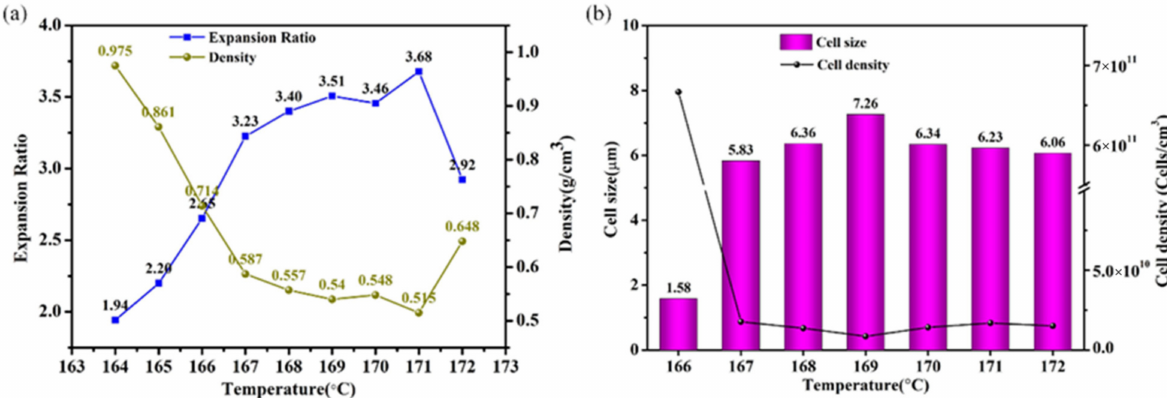
Figure 5. ( a ) The density and expansion ratio of the PVDF/10 wt% CNTs/10 wt% Ni foamed at different temperatures; ( b ) The cell size and cell density of the PVDF/10 wt% CNTs/10 wt% Ni foamed at different